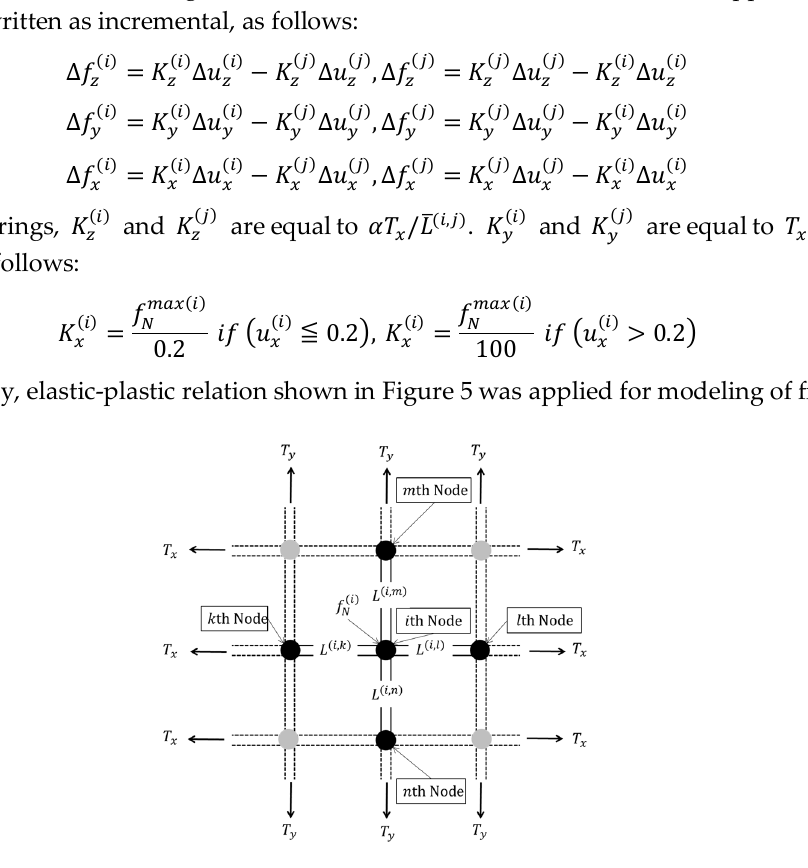
Figure 4. Positional relationships of nodes to calculate normal forces at cross-points of strings.